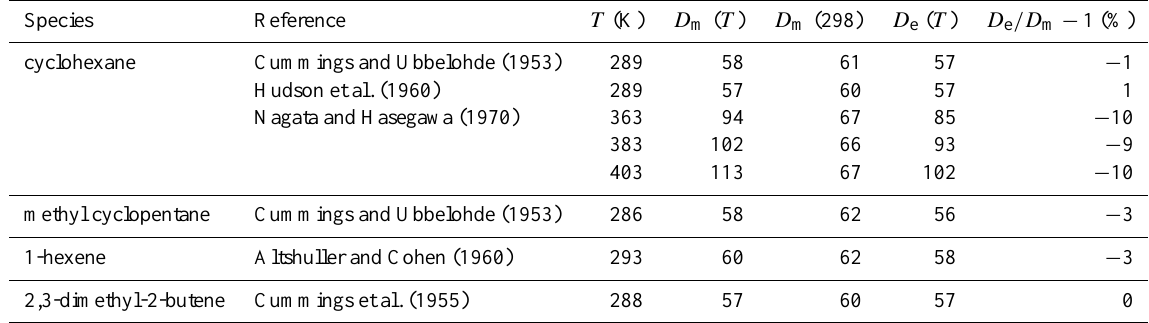
Table A1. Measured and estimated diffusivities of fours isomers with a formula of C 6 H 12 : cyclohexane, methyl cyclopentane, 1-hexene, and 2,3-dimethyl-2-butene. The unit for diffusivities is Torrcm 2 s − 1 . Species